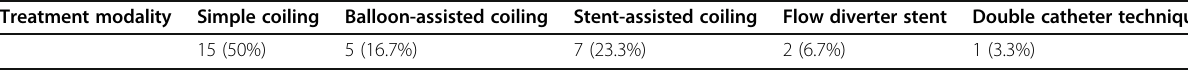
Table 2 Treatment modality regarding coiling, remodeling techniques Treatment modality Simple coiling